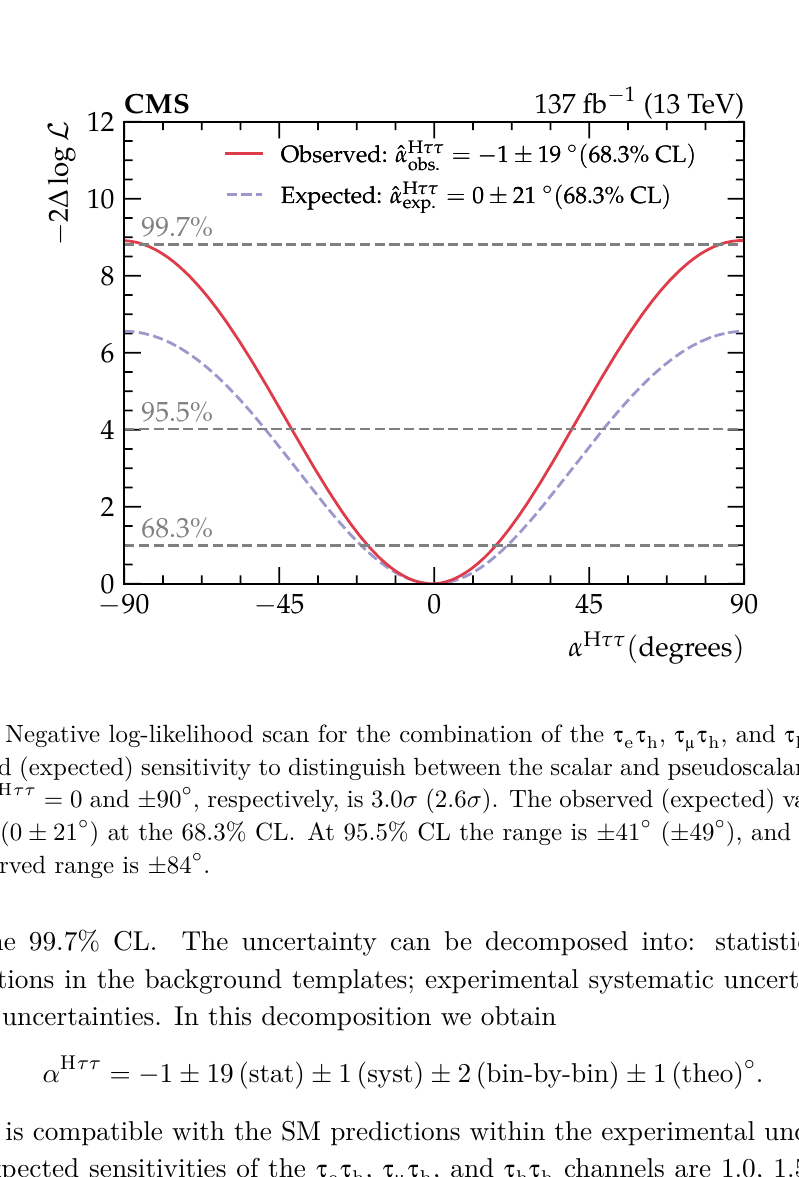
Figure 11 . Negative log-likelihood scan for the combination of the t The observed (expected) sensitivity to distinguish between the scalar and pseudoscalar hypotheses, defined at α H ττ = 0 and ± 90 ◦ , respectively, is 3 . 0 σ ( 2 . 6 σ ). The observed (expected) value for α H ττ is − 1 ± 19 ◦ ( 0 ± 21 ◦ ) at the 68.3% CL. At 95.5% CL the range is ± 41 ◦ ( ± 49 ◦ ), and at the 99.7% CL the observed range is ± 84 ◦